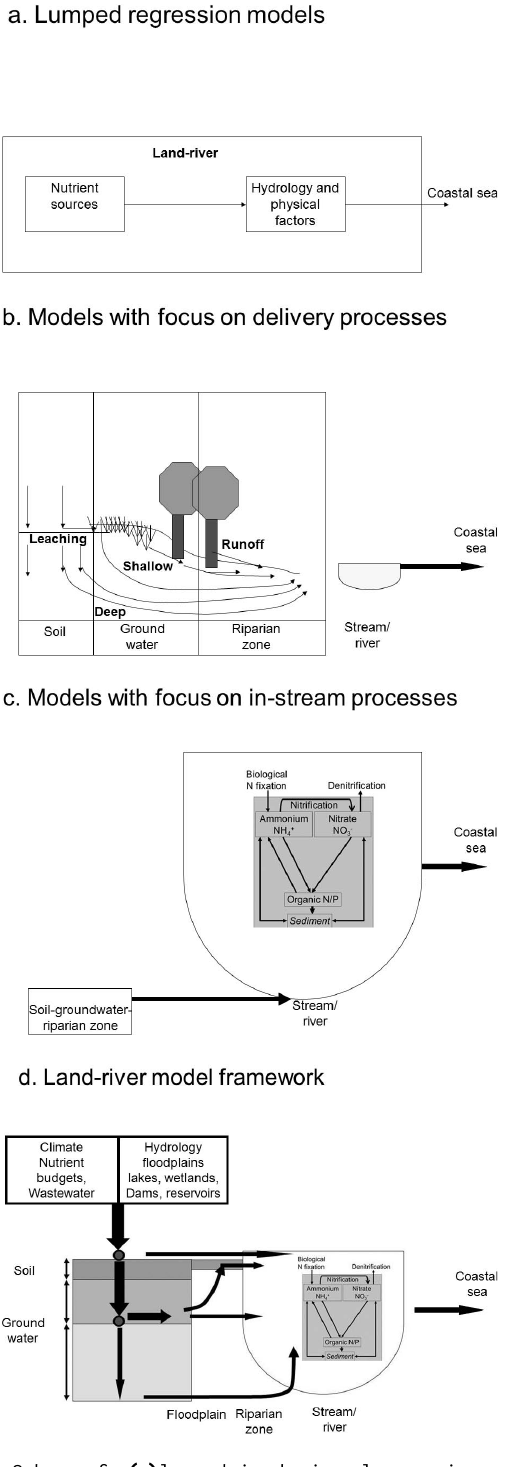
Fig. 3. Schemes for (a) lumped river-basin scale regression models; (b) models with focus on land-based nutrient delivery processes to streams; (c) models with focus on in-stream biogeochemical pro- cesses; (d) land–river model framework that adequately accounts for terrestrial and aquatic processes (in Fig. 3c and d, a simplified N cycle is